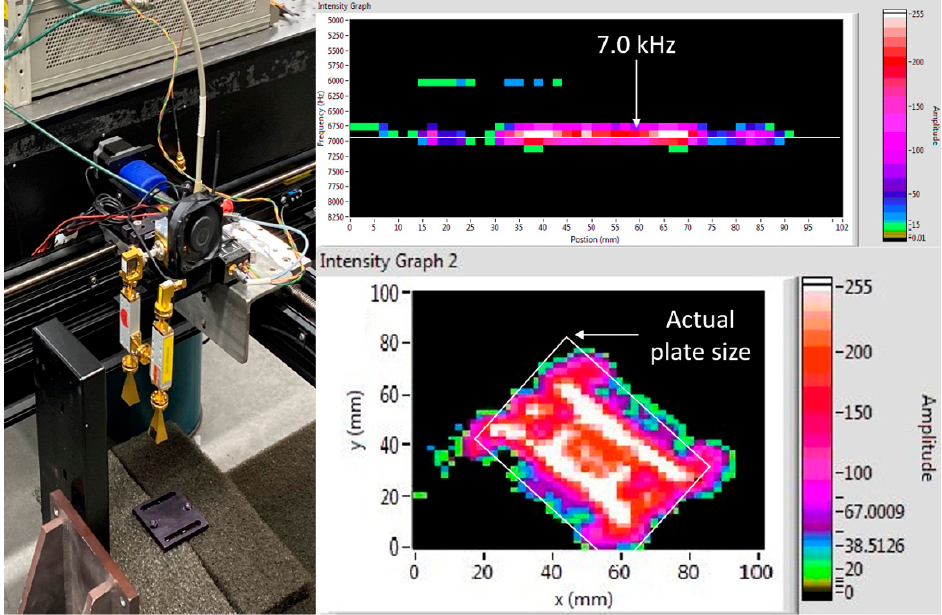
Figure 10. F-band Swept-FM 2D-scan imaging system and related experiment